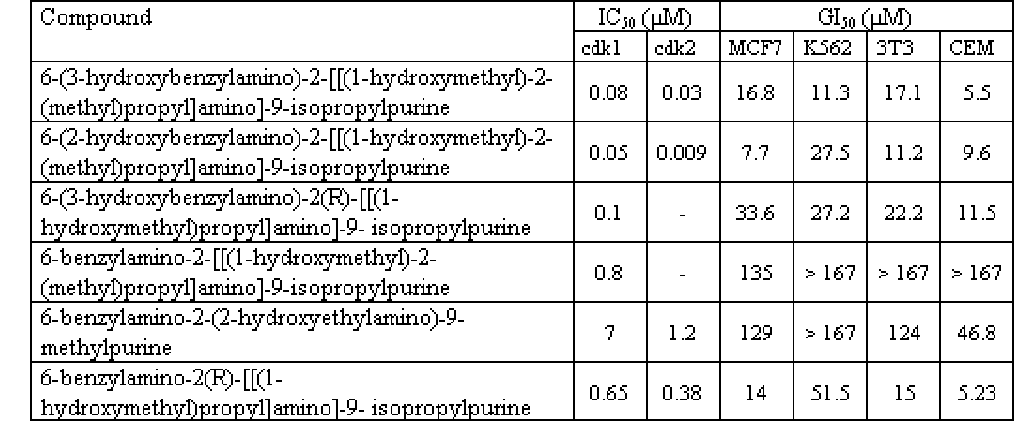
Table 1. Comparison of IC cdk2 and several Tumour Cell Lines.